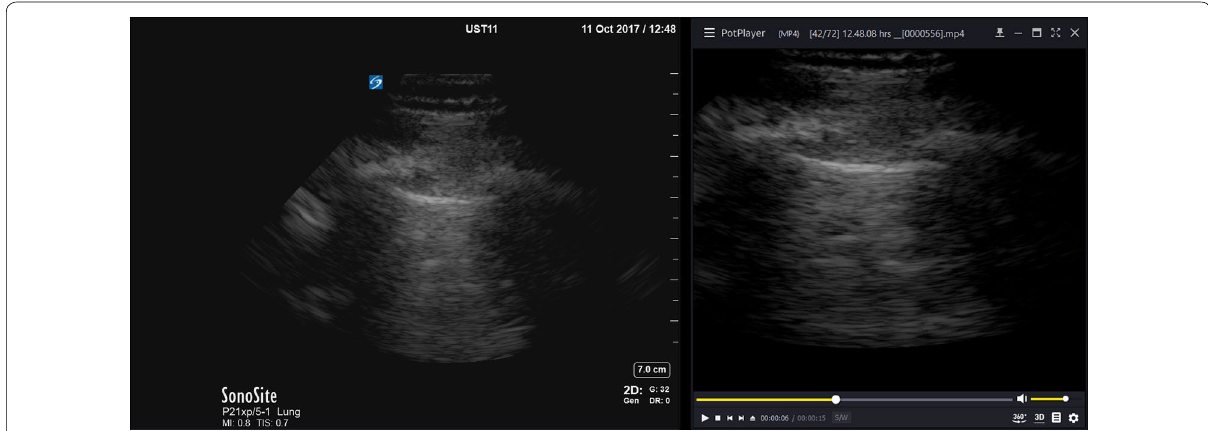
Fig. 3 A typical uncropped and cropped image of the pleural interface, acquired with the phased-array transducer. On the right, the cropped version is displayed as it was played back to the